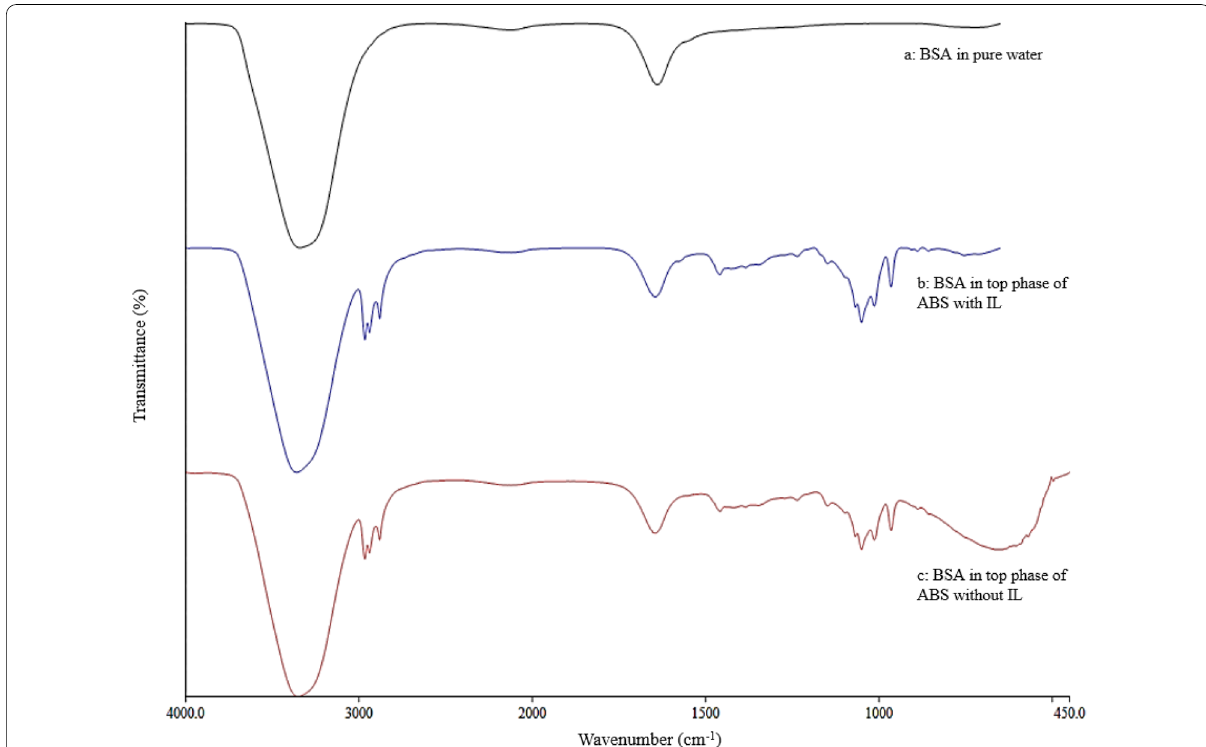
Fig. 7 FTIR spectra of BSA in various solution. a BSA in pure water; b BSA partitioned in the alcohol‑rich top phase of the 35% (w/w) 1‑propanol/22% (w/w) maltose ABS at pH 5 and added with 3% (w/w) [Bmim]Br; c BSA partitioned in the alcohol‑rich top phase of the 35%